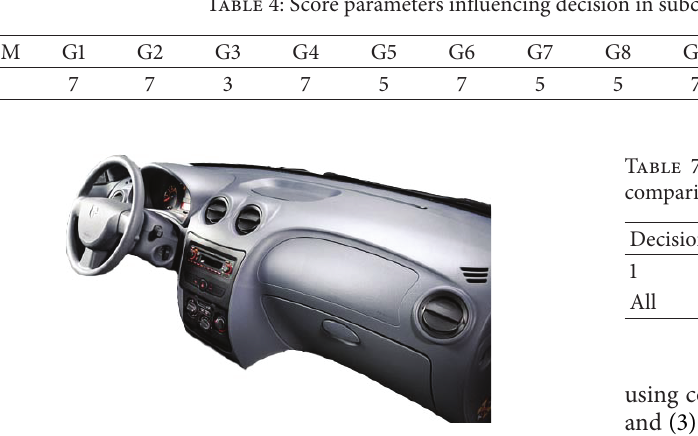
Figure 5: Runna automobile dashboard from Iran-Khodro automo- bile industry [41]. Table 5: CV and CVR results of final evaluation criteria.